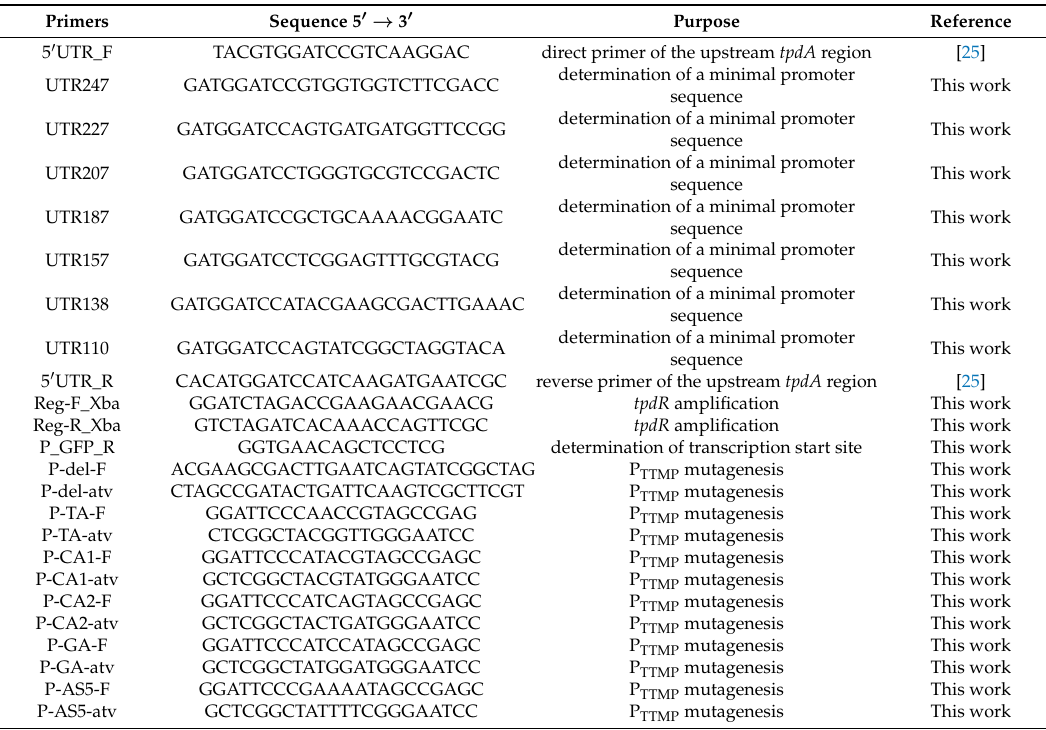
Table 2. Primers used during this